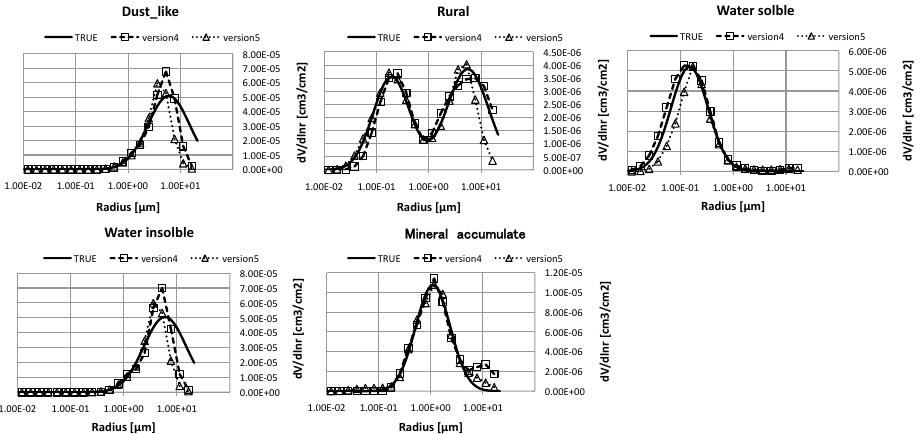
Fig. 6. SDF values derived by SKYRAD.pack version 4 and version 5 for the dust-like and rural aerosol types of WCP (Deepak and Gerber, 1983) and for the water soluble, water insoluble, and mineral accumulate aerosol types of Hess et al.